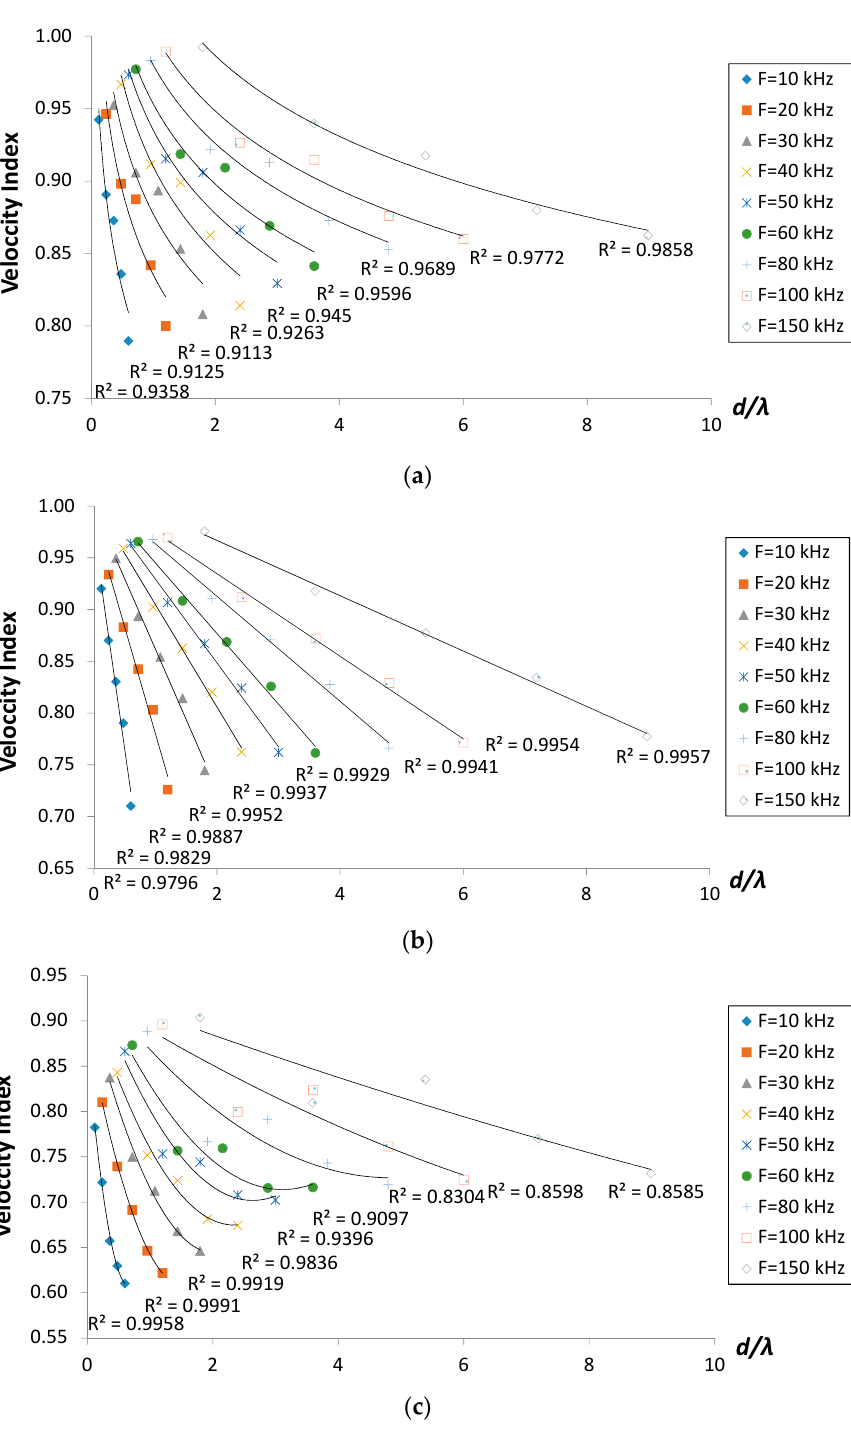
Figure 5. Velocity index versus d/ λ for crack cases ( a ) 30° inclined; ( b ) vertical (90°) and ( c ) 150° inclined.